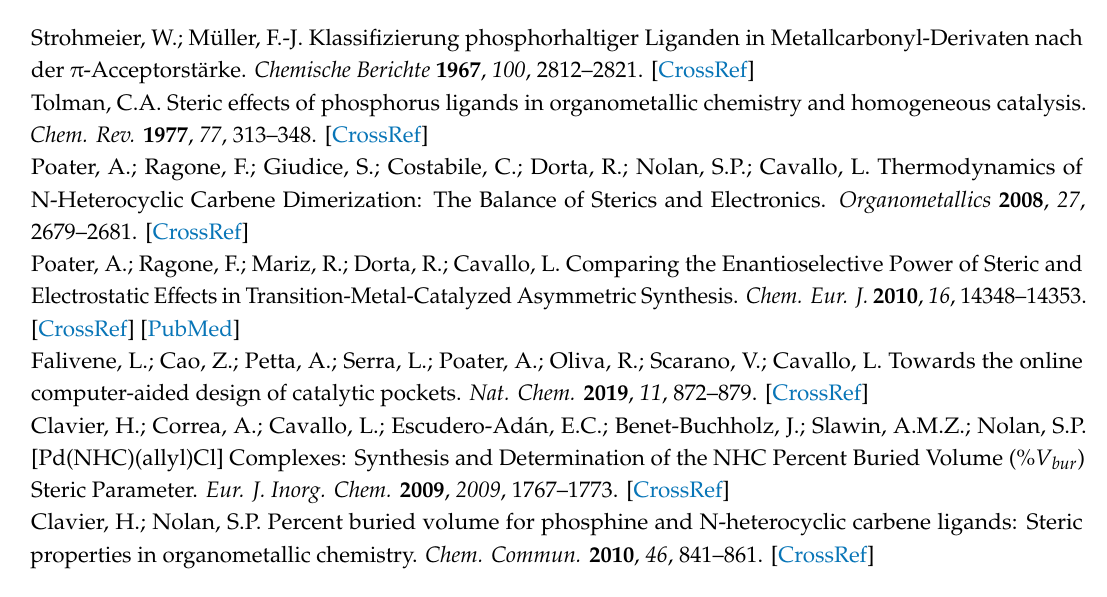
Supplementary Materials: The following are available online: Figure S1–S3: 3-Dimensional scatter plot with color-coded %V bur (PP), %V bur (NN + PP) or PLQY of all 100 compounds found, Table S1: Reported PLQY values for powder samples for Cu(I) complexes and %V bur for (NN), (PP), and (NN)(PP)